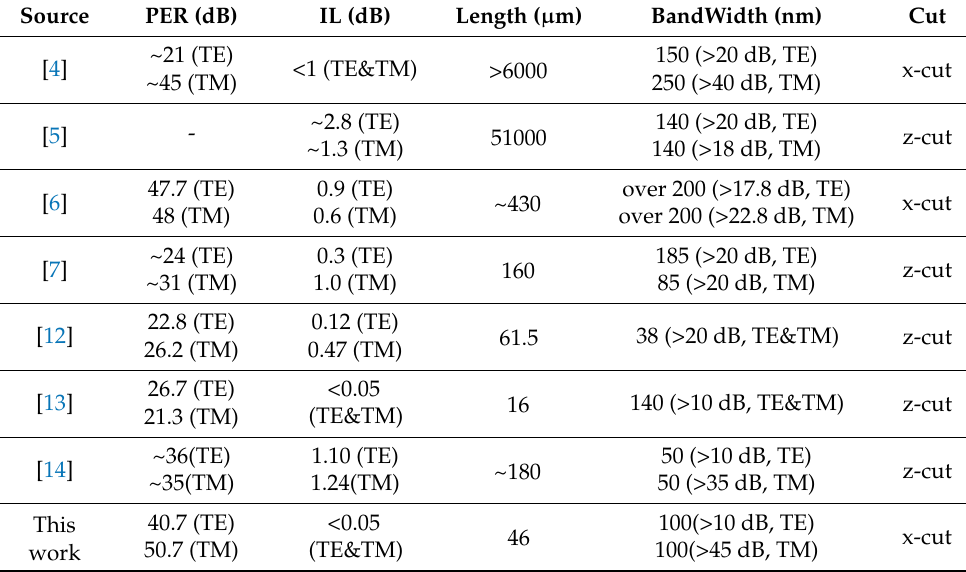
Table 1. Comparison of PBSs based on the LNOI